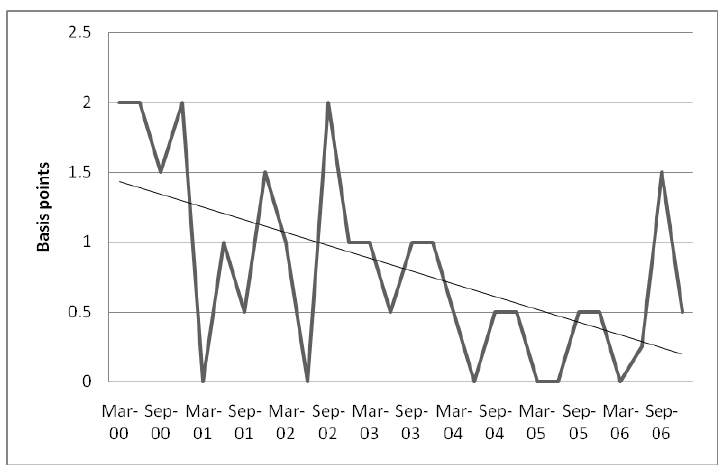
FIGURE 5: Cross-sectional dispersion in interest rate forecasts FIGURE 5a: 1-quarter-ahead